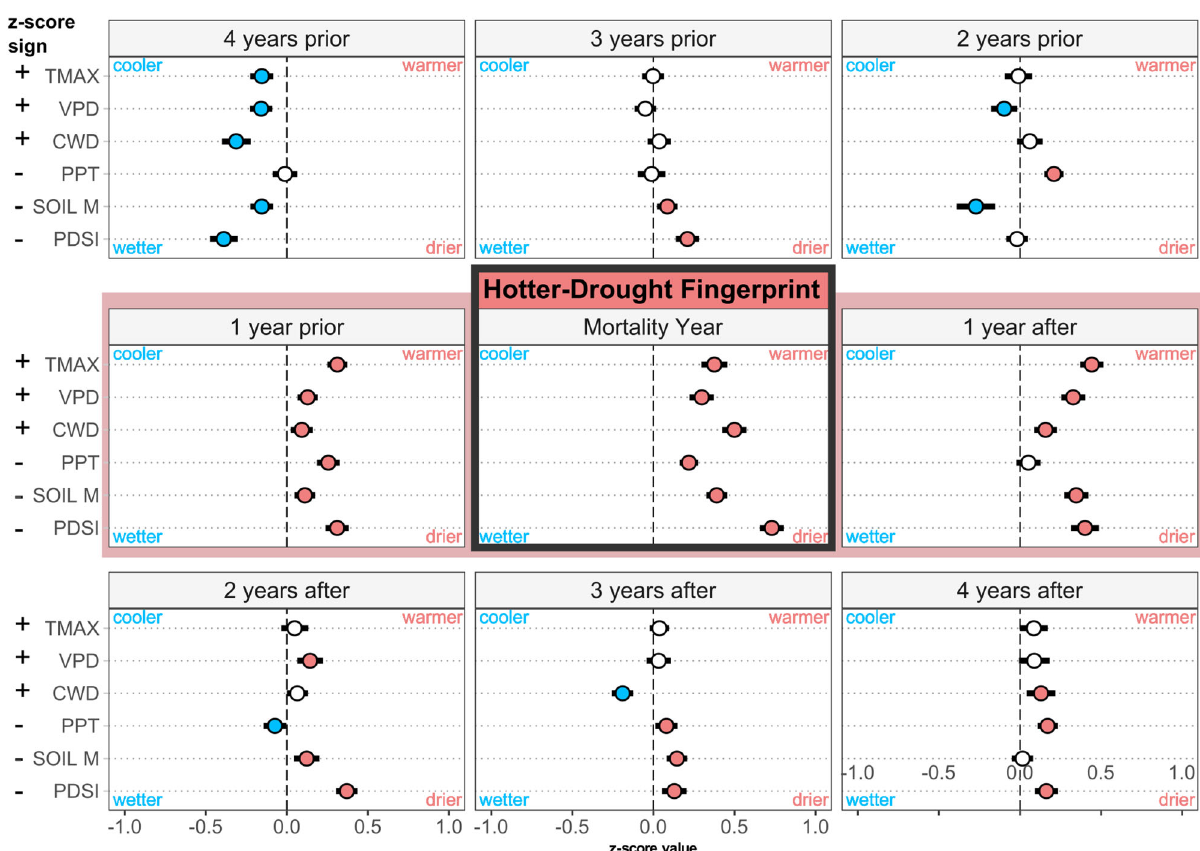
Fig. 3 Hotter-drought fi ngerprint of global tree mortality. The z -scores of climate variables during climatological warmest/driest months for the 4 years preceding, 4 years following, and during the onset of tree mortality events. For each variable, circles indicate the mean z -score of all sites ( n = 675), while whiskers represent the 95% con fi dence interval of that mean. Panels are arranged chronologically from left to right, top to bottom, from 4 years before mortality began through 4 years after. During the year of onset of mortality, a hotter-drought fi ngerprint on forest mortality events was revealed as the mean of plot z -scores for all climate variables signi fi cantly shifted toward values characteristic of warmer and drier conditions, with the year prior and the year following mortality showing similar, but weaker, tendencies (this 3-year window, centered on the year mortality began, is outlined in red). The z -scores for TMAX, VPD, and CWD are shown with their original sign, while the sign of z -scores for PPT, SOIL M, and PDSI were fl ipped such that positive indicates warm/dry, and negative indicates cool/wet across all variables. Point color represents the variable condition relative to long-term (1958 – 2019) climate: white indicates no difference, blue is signi fi cantly wetter/cooler, and red is signi fi cantly